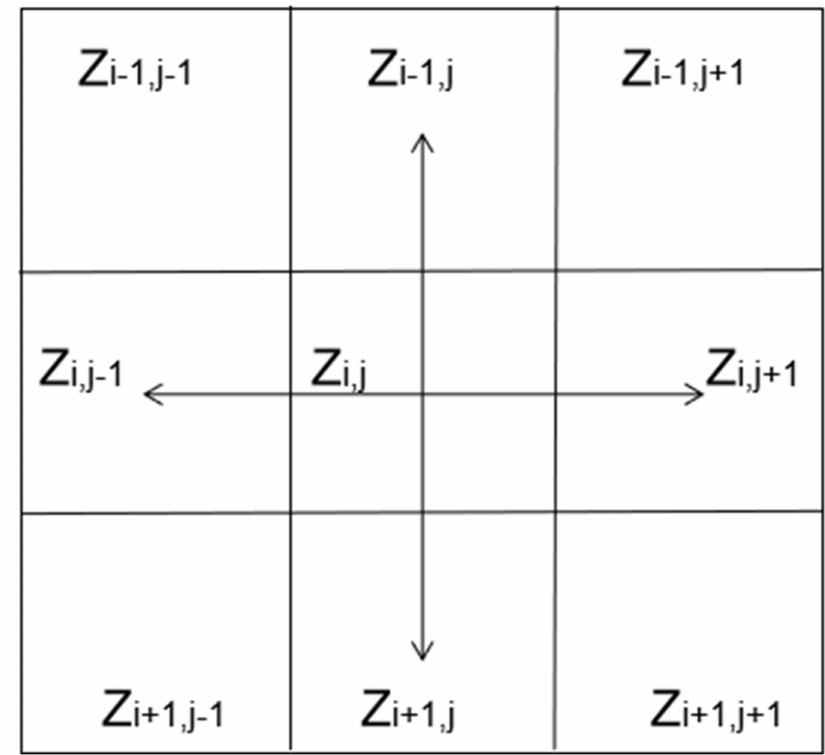
Figure 2. The central 3 × 3 window grid.